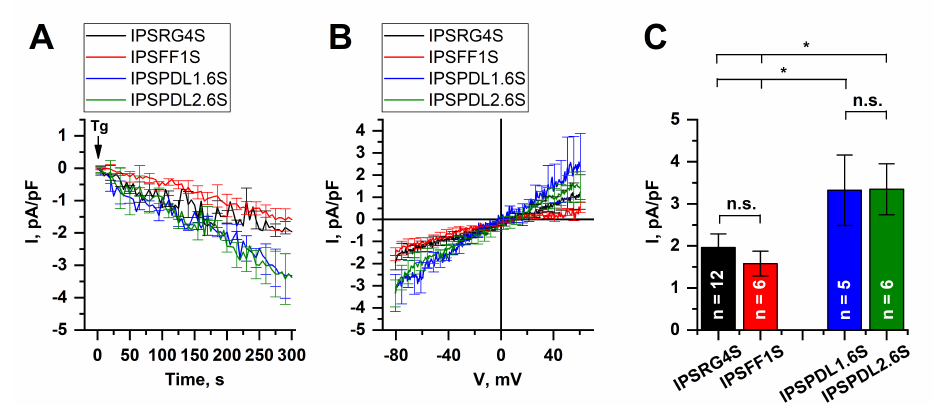
Figure 12. Store-operated calcium entry in iPSCs-derived dopaminergic neurons. ( A )— Normalized SOC currents evoked by application of thapsigargin (1 µ M) and represented as a function of time at a test potential of − 80 mV in iPSC-based DAns specific to PD patients (IPSPDL1.6S, blue line and IPSPDL2.6S, green line) and healthy donors (IPSRG4S, black line and IPSFF1S, red line). Each trace is represented as mean ± SEM. ( B )—Average I–V curves of normalized SOC currents evoked by the passive depletion of calcium stores with thapsigargin (1 µ M) in iPSC-based DAns specific to PD patients (IPSPDL1.6S, blue line and IPSPDL2.6S, green line) and healthy donors (IPSRG4S, black line and IPSFF1S, red line). The I–V curves were plotted at the steady-state level of the SOC currents. The number of experiments is depicted in panel ( C ). ( C )—Average amplitudes of the normalized SOC currents at the potential of − 80 mV in DAns specific to PD patients (IPSPDL1.6S, blue bar and IPSPDL2.6S, green bar) and healthy donors (IPSRG4S, black bar and IPSFF1S, red bar). The ampli- tudes are represented as mean ± SEM (n = number of single-cell experiments), n.s. indicates the absence of statistically significant differences ( p > 0.05). Asterisk indicates statistically significant differences ( p < 0.05).